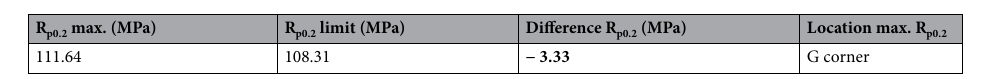
Table 8. Values of FEM simulation variant no. 1. Significant value is in